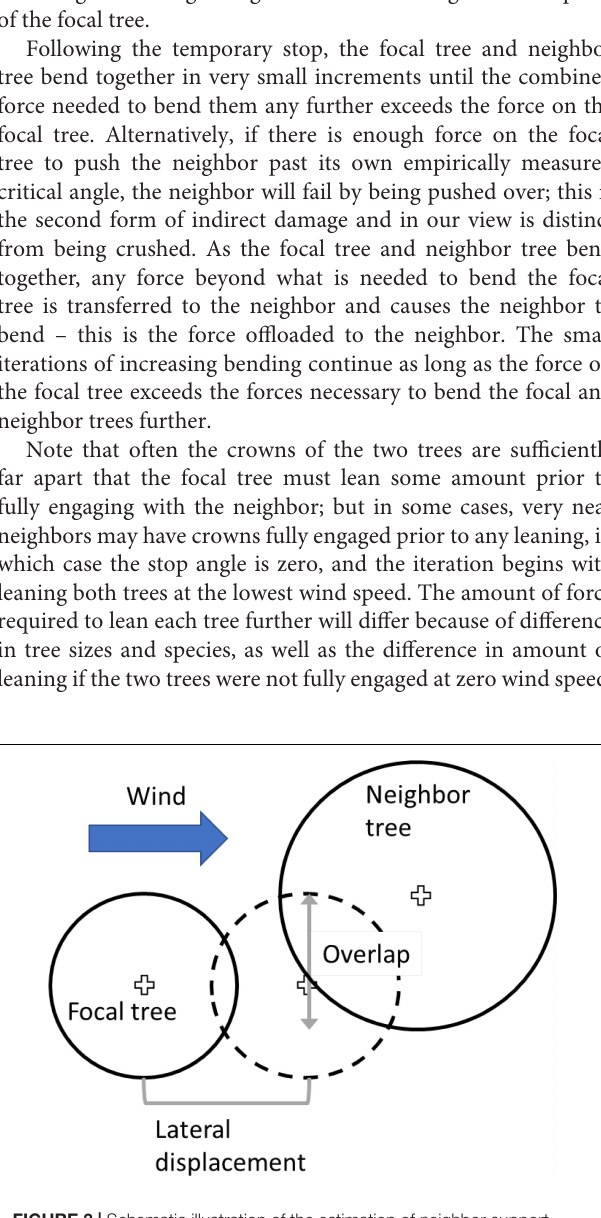
Frontiers in Forests and Global Change |